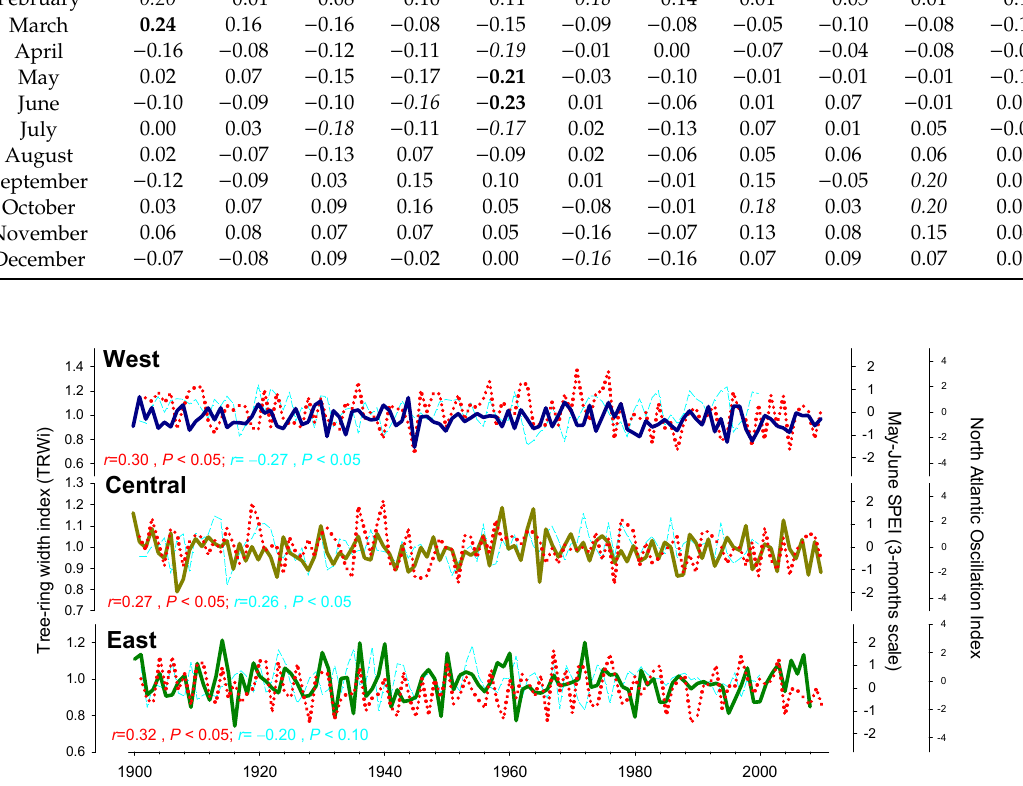
Figure 5. Composite regional chronologies (tree-ring width indices, TRWi; continuous lines) obtained for the studied sites and May to June Standardized Precipitation–Evapotranspiration Index (MJ–SPEI) drought index calculated at 3-month-long scales (dotted red lines) for the 1901–2010 period. The plotted drought index and NAO (dashed cyan line; winter for west, spring for central, and summer for east) were most strongly related to the tree-ring width indices (TRWi) in most study sites (see Figure 5). Pearson correlations (r) between TRWi and the indices and associated probability values ( P ) are shown for each site (see Figure 6 for more correlations).